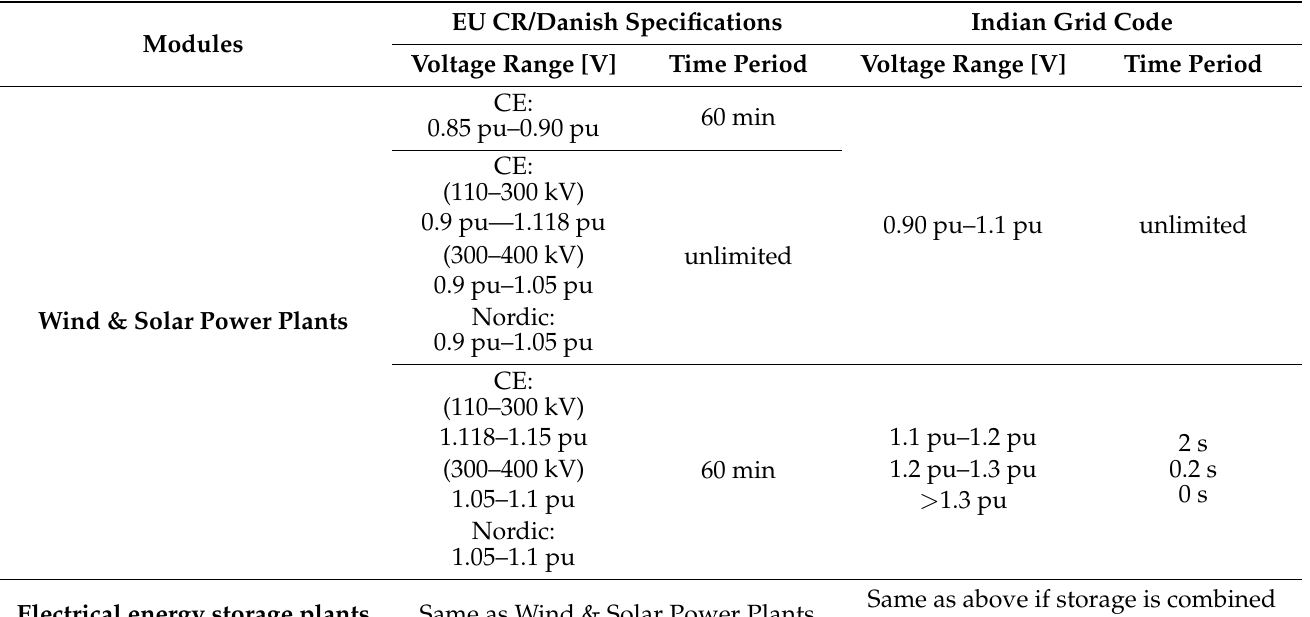
Table 3. Operational voltage range in Denmark and India for Normal Operation.